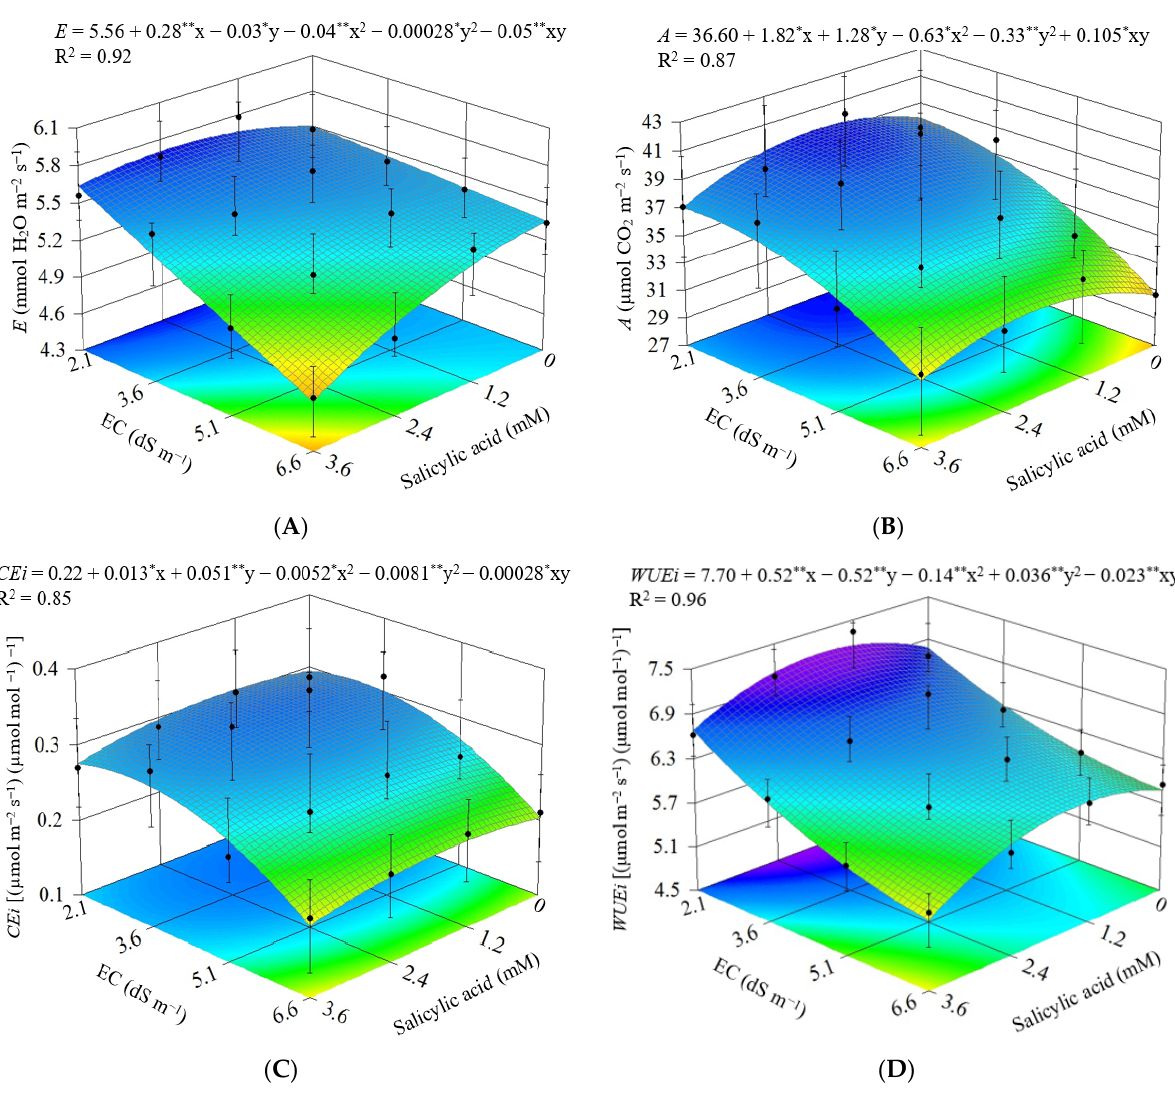
Figure 5. Response surface for transpiration— E ( A ), CO 2 assimilation rate— A ( B ), instantaneous carboxylation efficiency— CEi ( C ), and instantaneous water use efficiency— WUEi ( D ) of ‘Canindé’ okra cultivated in a hydroponic system as a function of the interaction between the electrical conductivity of the nutrient solution (EC) and the concentrations of salicylic acid at 60 days after transplanting. X and Y—Concentration of salicylic acid and EC, respectively; * and ** significant at a p ≤ 0.05 and ≤ 0.01, respectively. The vertical lines represent mean +/ − standard error (n =